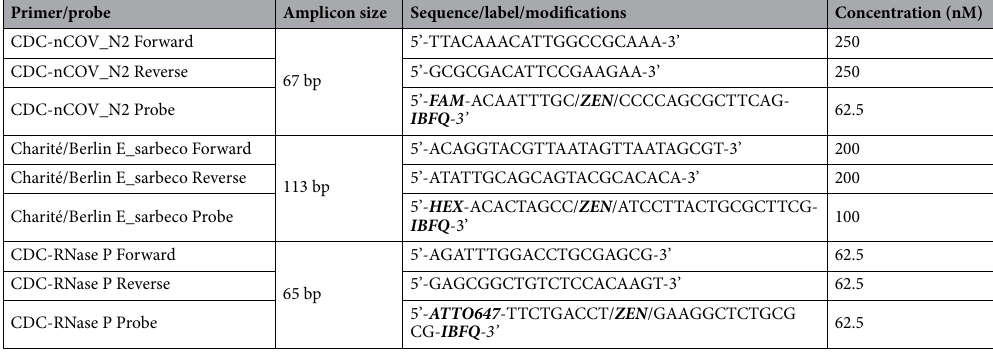
Table 1. Primers and probes used in the assay, with respective sequences, modifications, and final qPCR